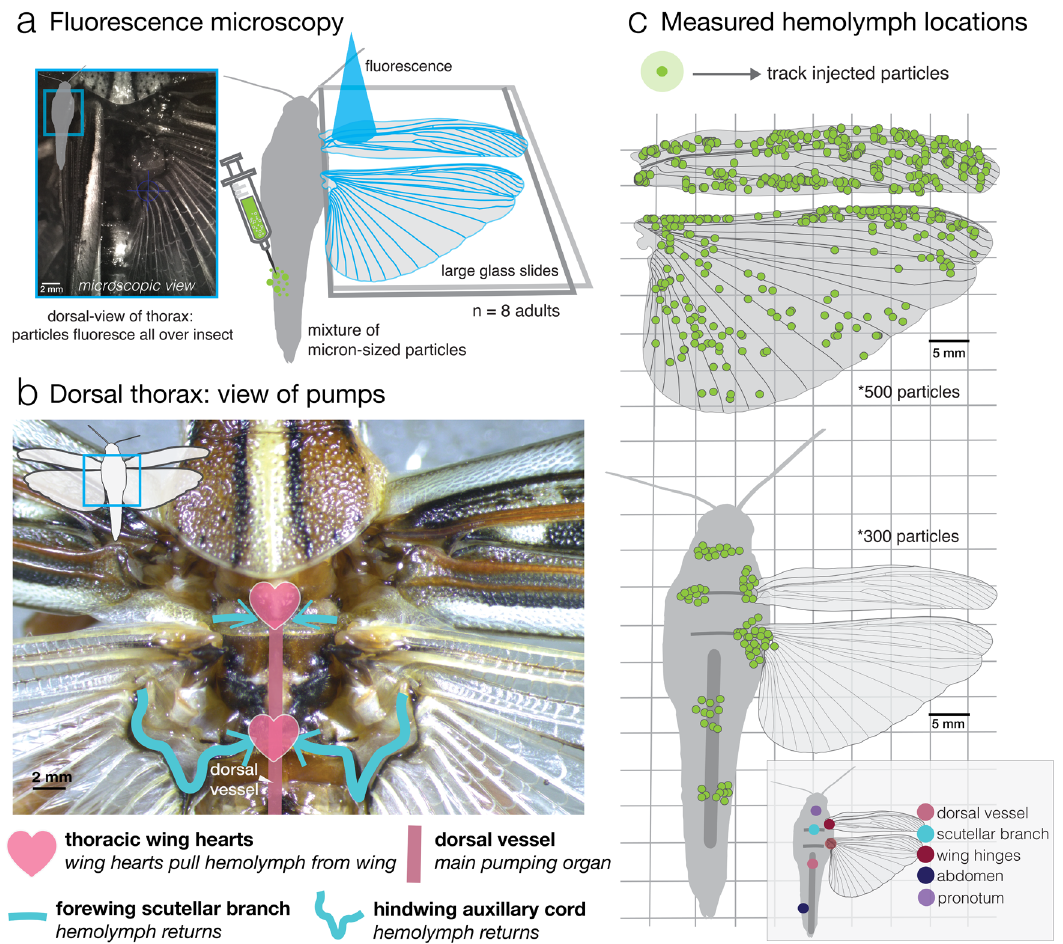
Fig. 2 Visualizing and quantifying hemolymph fl ow via fl uorescent particle tracking in S. americana . a View of the dorsal thorax of a grasshopper under a fl uorescent microscope (left). Live insects were injected with neutrally buoyant fl uorescent particles. Before imaging and particle injection, S. americana was brie fl y anesthetized with carbon dioxide and quickly restrained with modeling clay; wings were spread between two glass slides (blue light indicates fl uorescence). b Dorsal view indicates the location of thoracic wing hearts and return conduits into the wing heart pump. The dorsal vessel dominates the pumping of hemolymph within an insect, but cannot circulate hemolymph into the wings without the assistance of thoracic wing hearts, which pump hemolymph from the wing. c Wing map (normalized coordinates) of all particles (500 total) tracked and quanti fi ed across 8 adult grasshoppers in both the forewing and hindwing (16 wings total). Body map of measured particles (300 total) across the